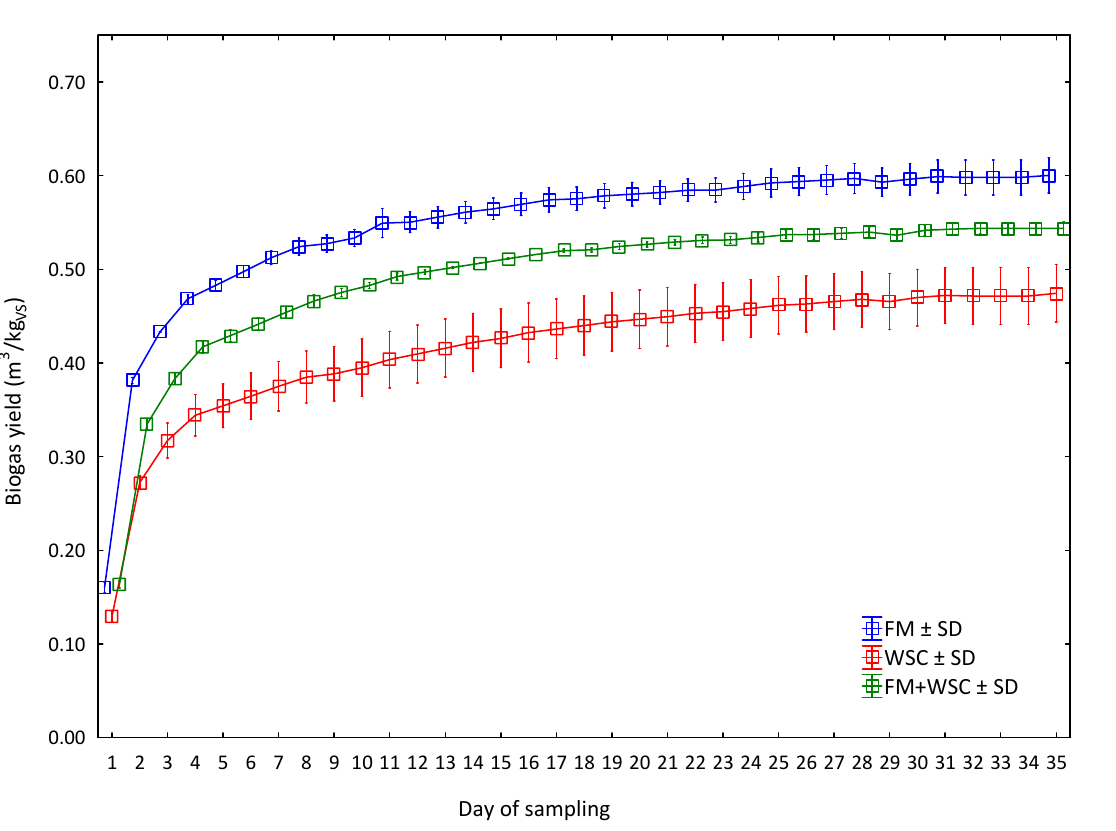
Figure 4. Biogas yield during 35 days of the assay (average values for every day of measurement (n = 3) for one measurement, ± SD). FM = fodder mallow; WSC = white sweet clover; FM + WSC = fodder mallow + white sweet clover.